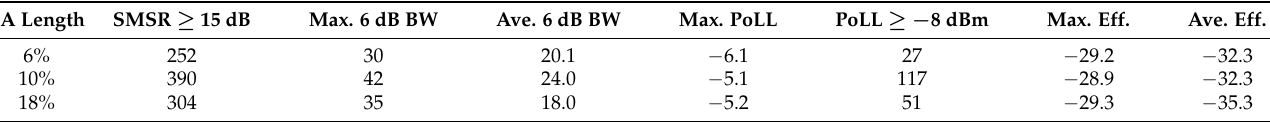
Table 1. List of important parameters from the devices tested. Saturable absorber length, as a total fraction of the cavity length, is listed as percentage in column one. The number of states measured with a side mode suppression ratio greater than 15 dB (SMSR ≥ 15 dB) are listed in column two. The number of comb lines in the state with the largest 6 dB bandwidth is listed in column three. The average bandwidth of all states with SMSR ≥ 15 dB is listed in column four. The power of the lowest line (PoLL) of a contiguous 20 line comb is listed in column five in dBm. The number of states with a PoLL ≥ − 8 dBm is listed in column six. The maximum wall plug efficiency of the lowest line (WPE20) is listed in column seven in dB. The average WPE20 of all states with SMSR ≥ 15 dB is listed in column eight in dB.